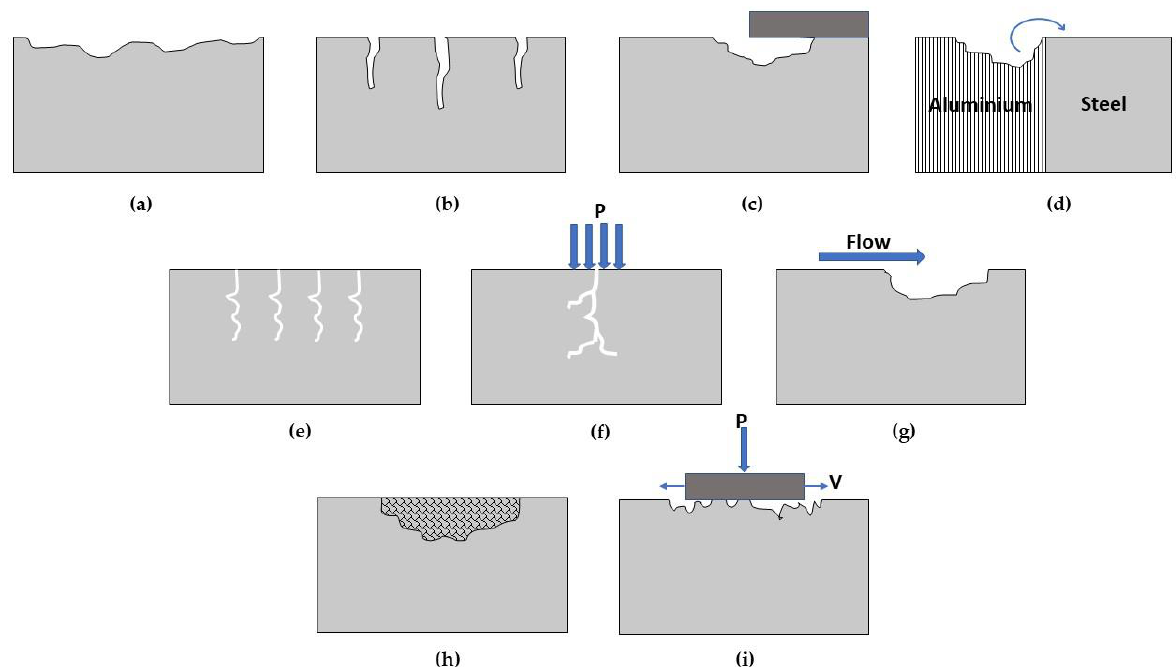
Figure 2. Prevalent forms of corrosion in steel structures: ( a ) uniform; ( b ) pitting; ( c ) crevice; ( d ) galvanic; ( e ) fatigue; ( f ) stress; ( g ) erosion; ( h ) intergranular; and ( i ) fitting corrosion.